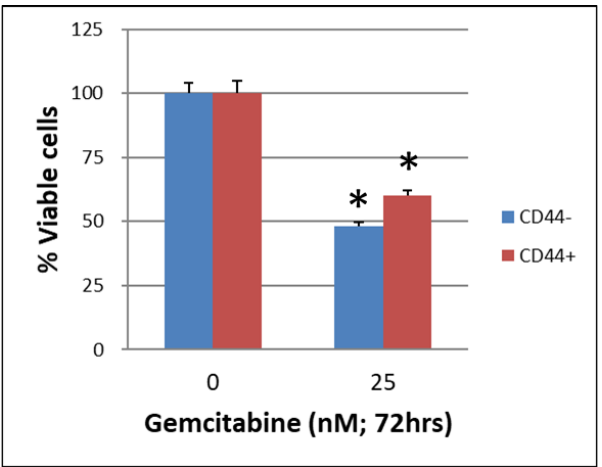
Figure 1. The survival of cancer stem cells CD44+/CD44− of BxPC-3 PDAC cells treated with or without gemcitabine (25 nM, 72 h) is shown. The CD44+ had better survival than CD44−, * < 0.05. (Mean ± SD).